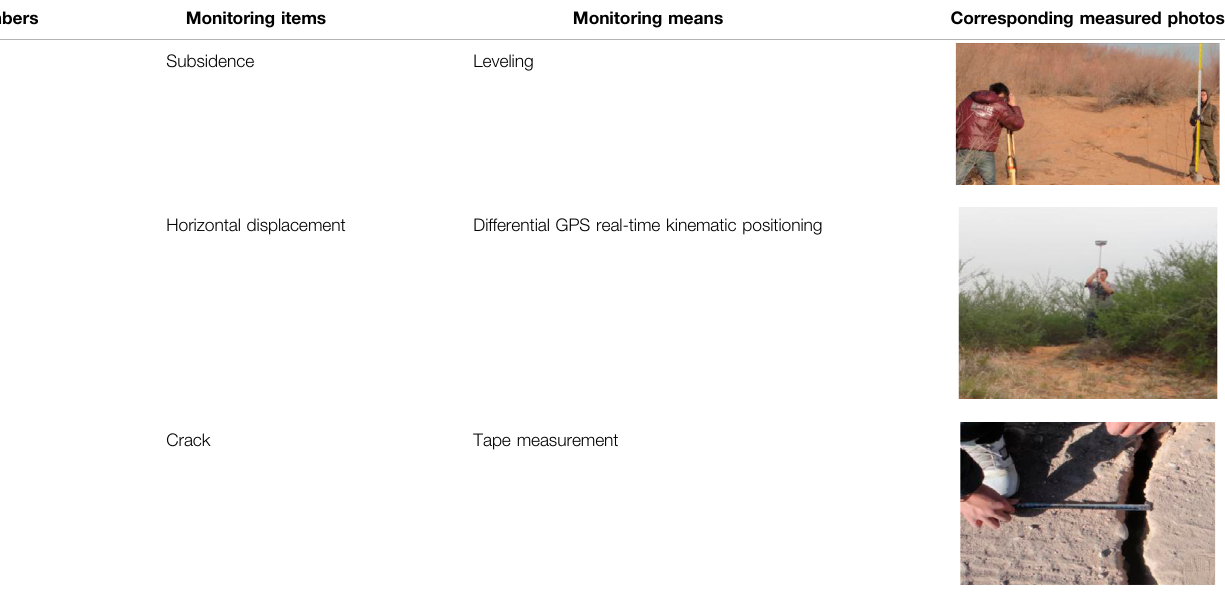
TABLE 1 | Monitoring items and